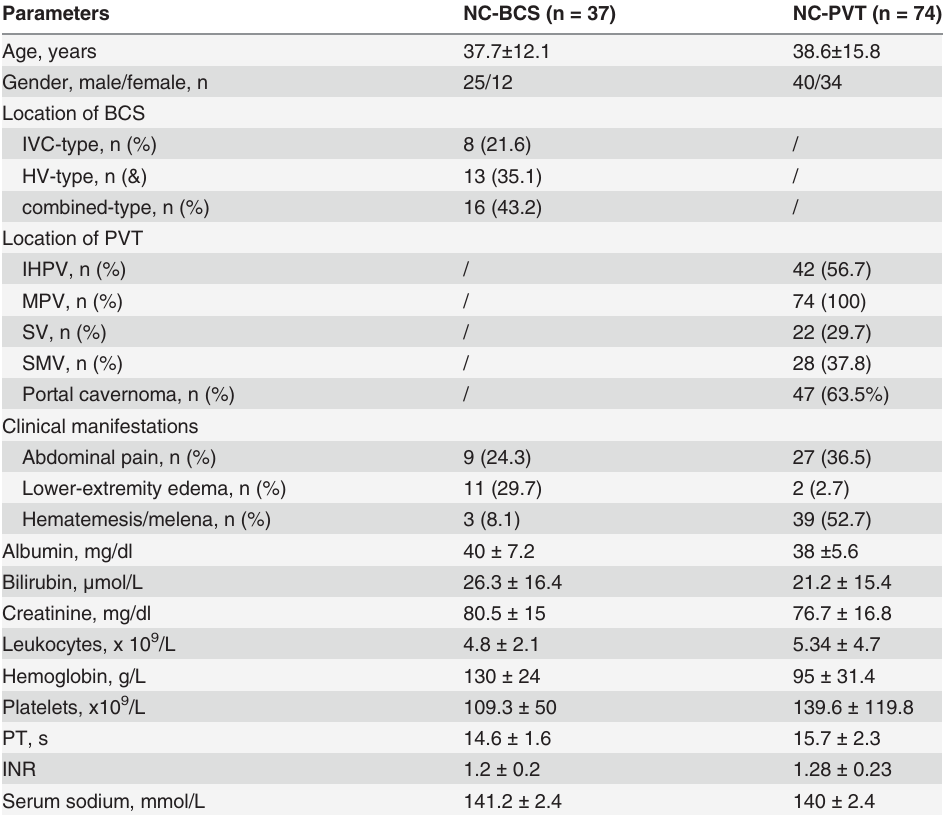
Table 1. Demographic characteristics of patients with NC-BCS and NC-PVT.